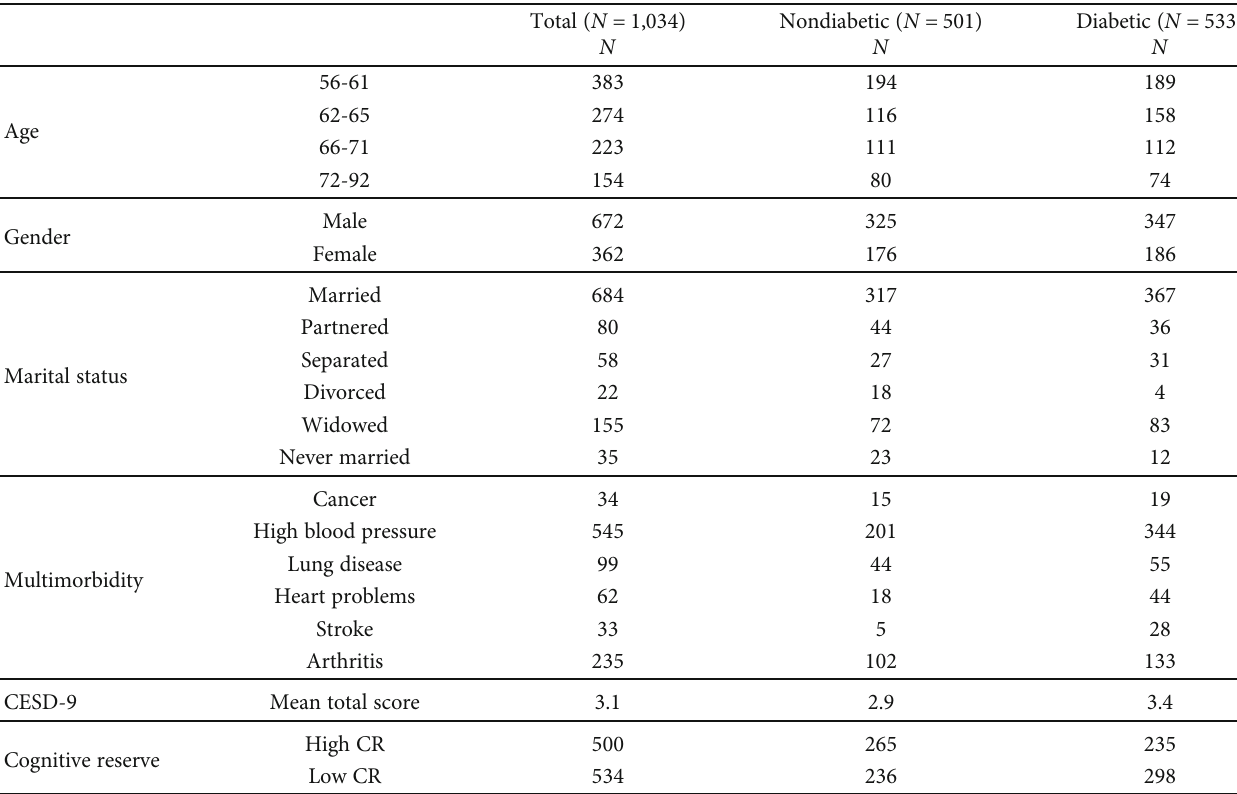
Table 1: Sociodemographic and clinical characteristics of the study sample ( N = 1033